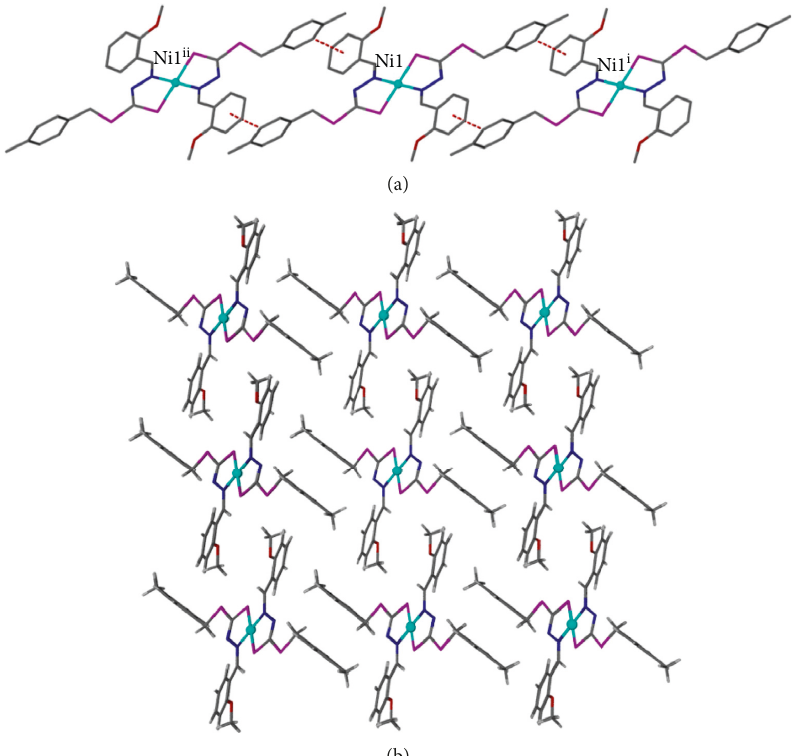
Figure 5: (a) π - π interactions between the neighbouring complexes. Symmetry elements used: i � 1+ x , y , z − 1; ii � 1 − x , − y , 3 − z . (b) Interdigitating arrangement of the aromatic rings within 3